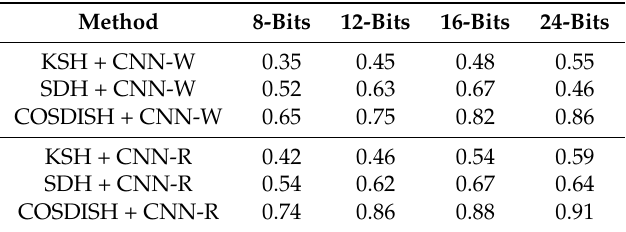
Table 2. The mean average precision (MAP) of different hashing methods with varied CNN features and code length on AID